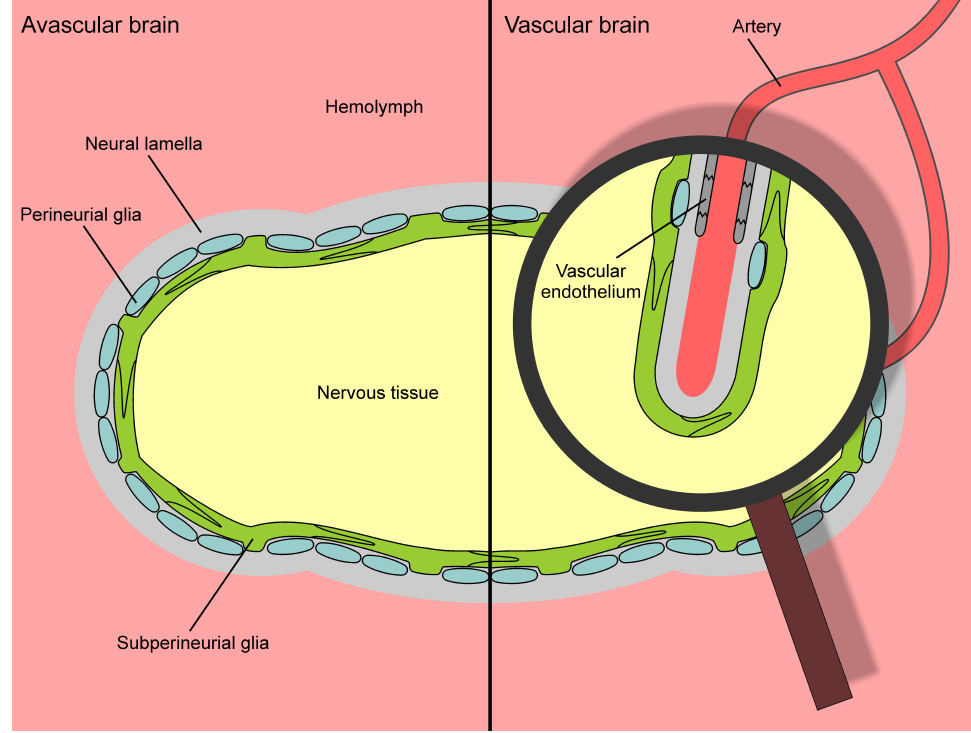
Figure 4. Schematic representation of the blood-brain barrier in arthropods. Cross section of an arthropod brain. Avascular supply of the brain ( left ) as found, e.g., in insects: The brain is surrounded by lacunae filled with hemolymph which bathes and thus supplies the brain. Vascular supply of the brain ( right ) as found, e.g., in decapod crustaceans and some arachnids (such as spiders and scorpions): arteries enter the brain and at their open endings release hemolymph into fine lacunae. A BBB exists between the nervous tissue and both the fine intracerebral lacunae as well as the lacunae surrounding the